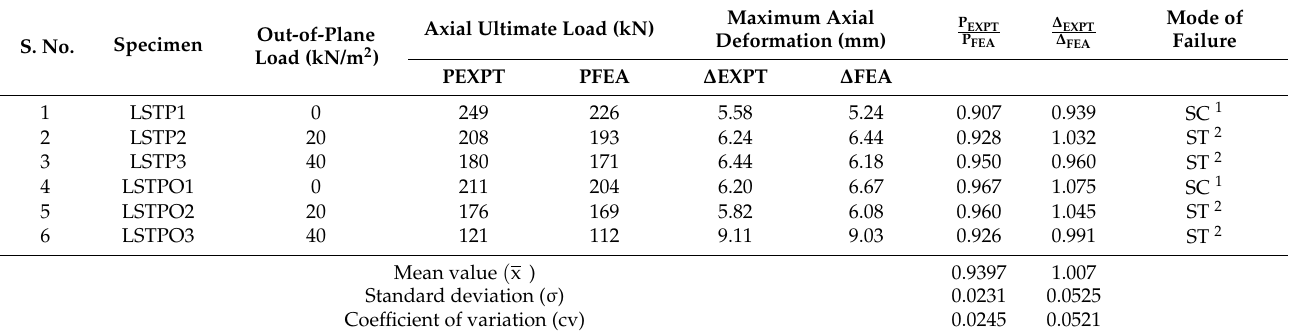
Figure 22. Out-of-plane load vs. deflection curve for GFRP-stiffened composite plates. ( a ) LSTP4 ( b ) LSTPO4. Table 5. Axial ultimate loads were obtained from the experiment and FEA.